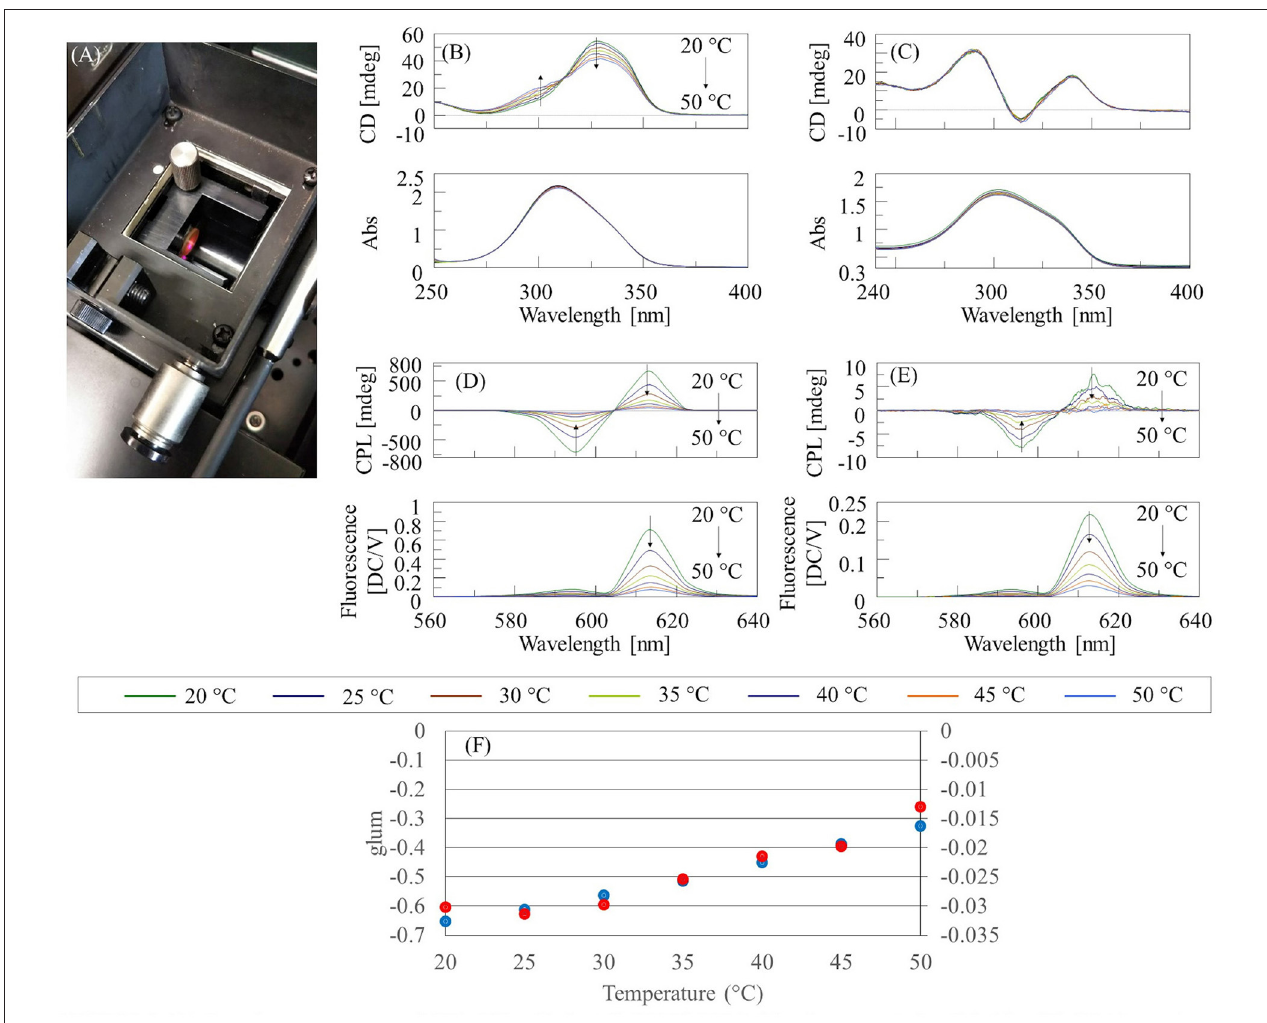
FIGURE 2 | (A) Sample compartment of CPL-300 with installed PTC-510 Peltier thermostatted cell holder (B) CD/absorption spectra of Eu(facam) 3 /DMSO, (C) CD/absorption spectra of Eu(facam) 3 /KBr pellet, (D) CPL/fluorescence spectra of Eu(facam) 3 /DMSO, (E) CPL/fluorescence spectra of Eu(facam) 3 /KBr pellet, and (F) g lum for DMSO solution (blue) and KBr pellet (red) at 596nm.